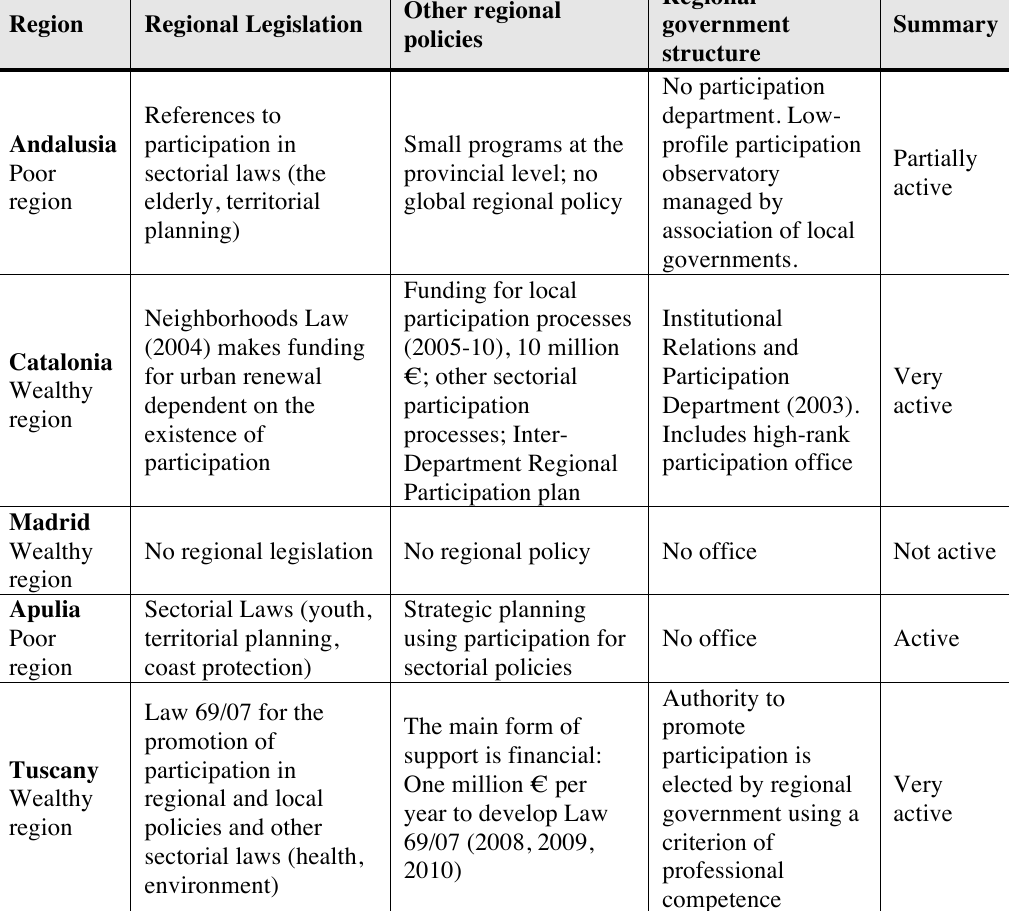
Table 1. Main characteristics of each of the regions’ participation